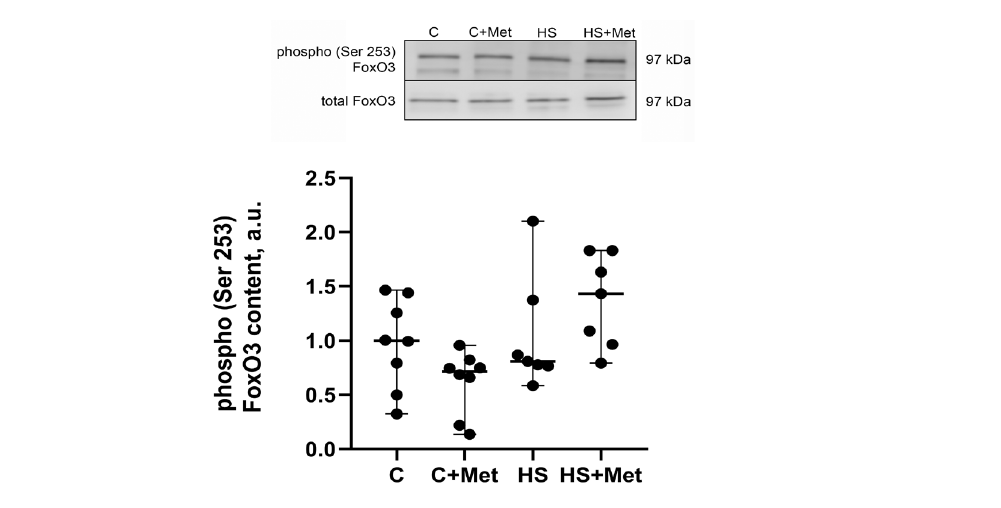
Figure 10. Effect of metformin pre-treatment on FoxO3 (Ser 253) phosphorylation in rat soleus muscle. C, vivarium control, C+Met, vivarium control + metformin pre-treatment, HS, 7-day hindlimb suspension, HS+Met, metformin pre-treatment + 7-day hindlimb suspension. Scatter dot plot indicates median values, and the whiskers represent minimum and maximum values; n = 7–8/group. The expression levels of muscle-specific E3 ubiquitin ligases, MuRF1 and MAFbx/atrogin-1, were significantly increased in rat soleus muscle in both HS and HS+Met groups compared to the control group (Figure 11).